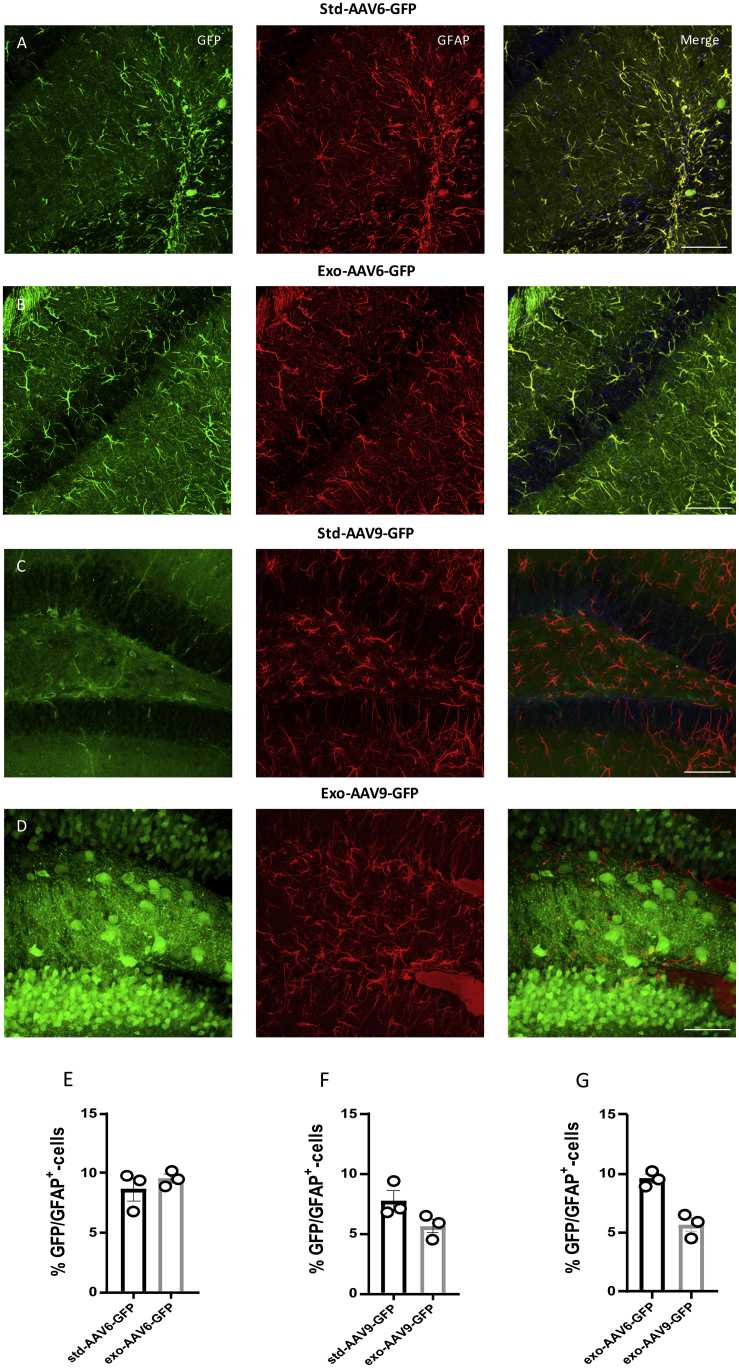
Conjugated Exosome AAV Is Not Sufficient to Mediate the Transduction of Astrocytes(A and B) Co-localization of GFP (green) with the astrocyte marker GFAP (red) expressed by (A) std-AAV6 and (B) exo-AAV6 vectors. (C and D) Co-localization of GFP (green) with GFAP (red) expressed by (C) std-AAV9 and (D) exo-AAV9 vectors. Slices were stained for astrocyte marker GFAP at 3 months after bilateral injection into the hippocampus. Images were captured by a Leica SP8 confocal microscope at 40× magnification. The merge image of both channels (GFP-GFAP) is on the right panel. Scale bar 20 μm. (E and F) Quantification of GFP-GFAP-positive cells expressed as a percentage of total GFP-positive cells between (E) std-AAV6 and exo-AAV6 and (F) std-AAV9 and exo-AAV9 (n = 12). (G) No significant difference between exo-AAV6 and exo-AAV9 vectors. The data were analyzed by two-way ANOVA with Tukey post hoc test. Data are presented as mean ± SEM.